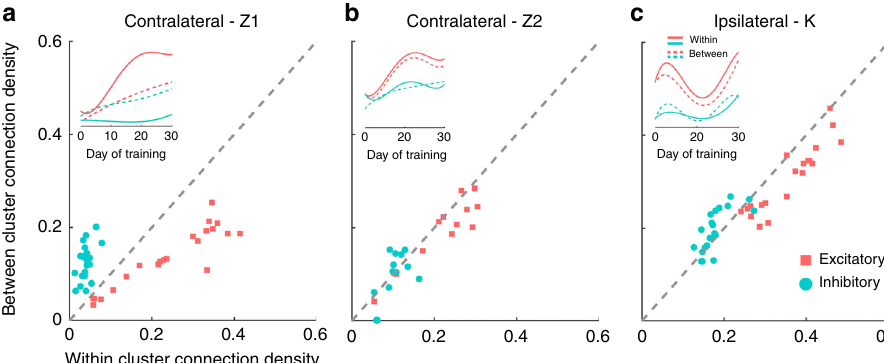
Fig. 4 Excitatory and inhibitory connection density within and between the reach and grasp clusters. a – c The connection density within vs. across clusters for excitatory (red points) and inhibitory (blue points) connections. Each point corresponds to a given training day. Gray dashes correspond to the identity line. Inset shows the temporal dynamics of the connections resolved by clusters. Solid lines represent within-cluster connection density and dashed lines represent between-cluster